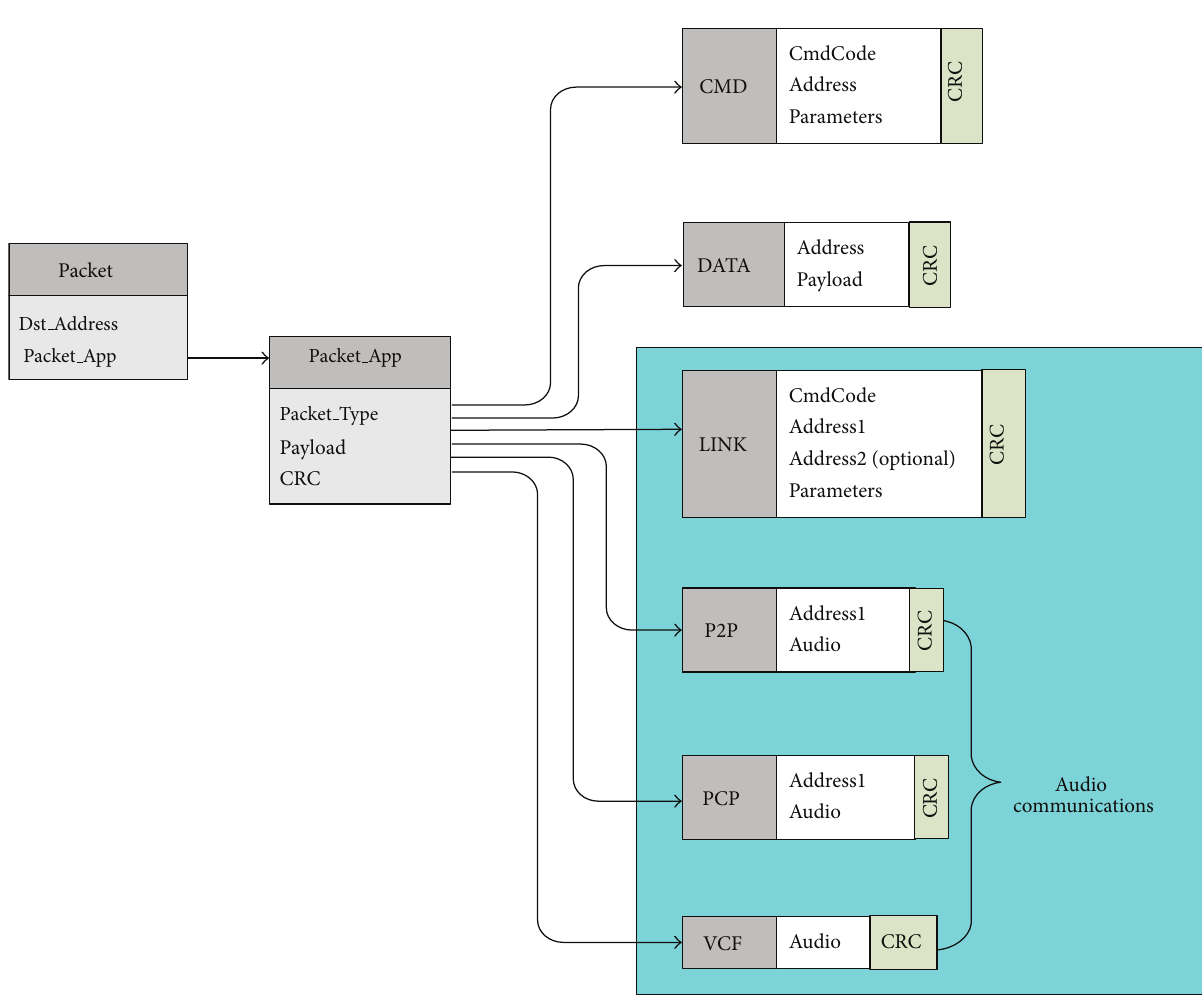
Figure 5: Packets